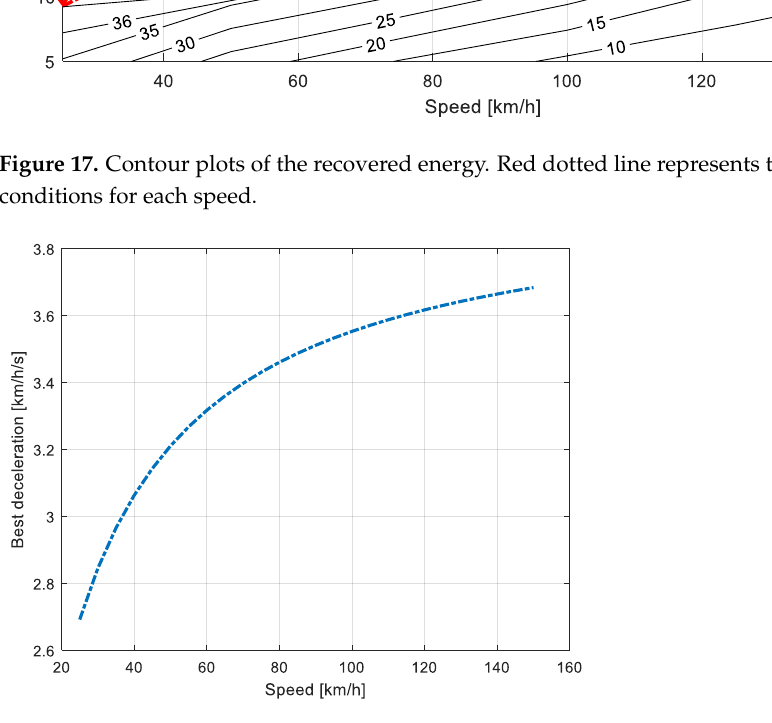
Figure 18. Optimal deceleration as a function of the starting speed.